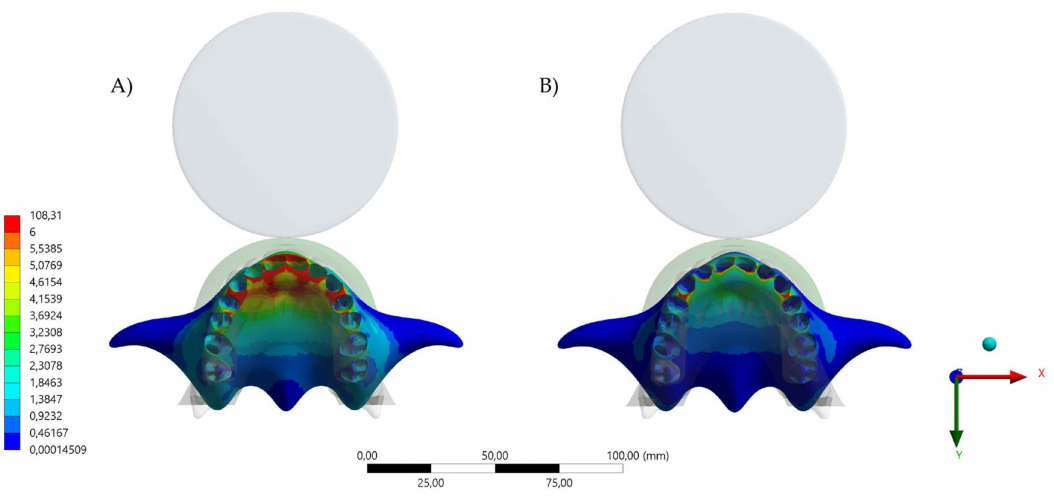
Figure 8. Von Mises stress result in the bone tissue. ( A ) Occlusal view of the maxillary bone stresss with the conventional design and ( B ) occlusal view of the maxillary bone stress with the hybrid (HMG)